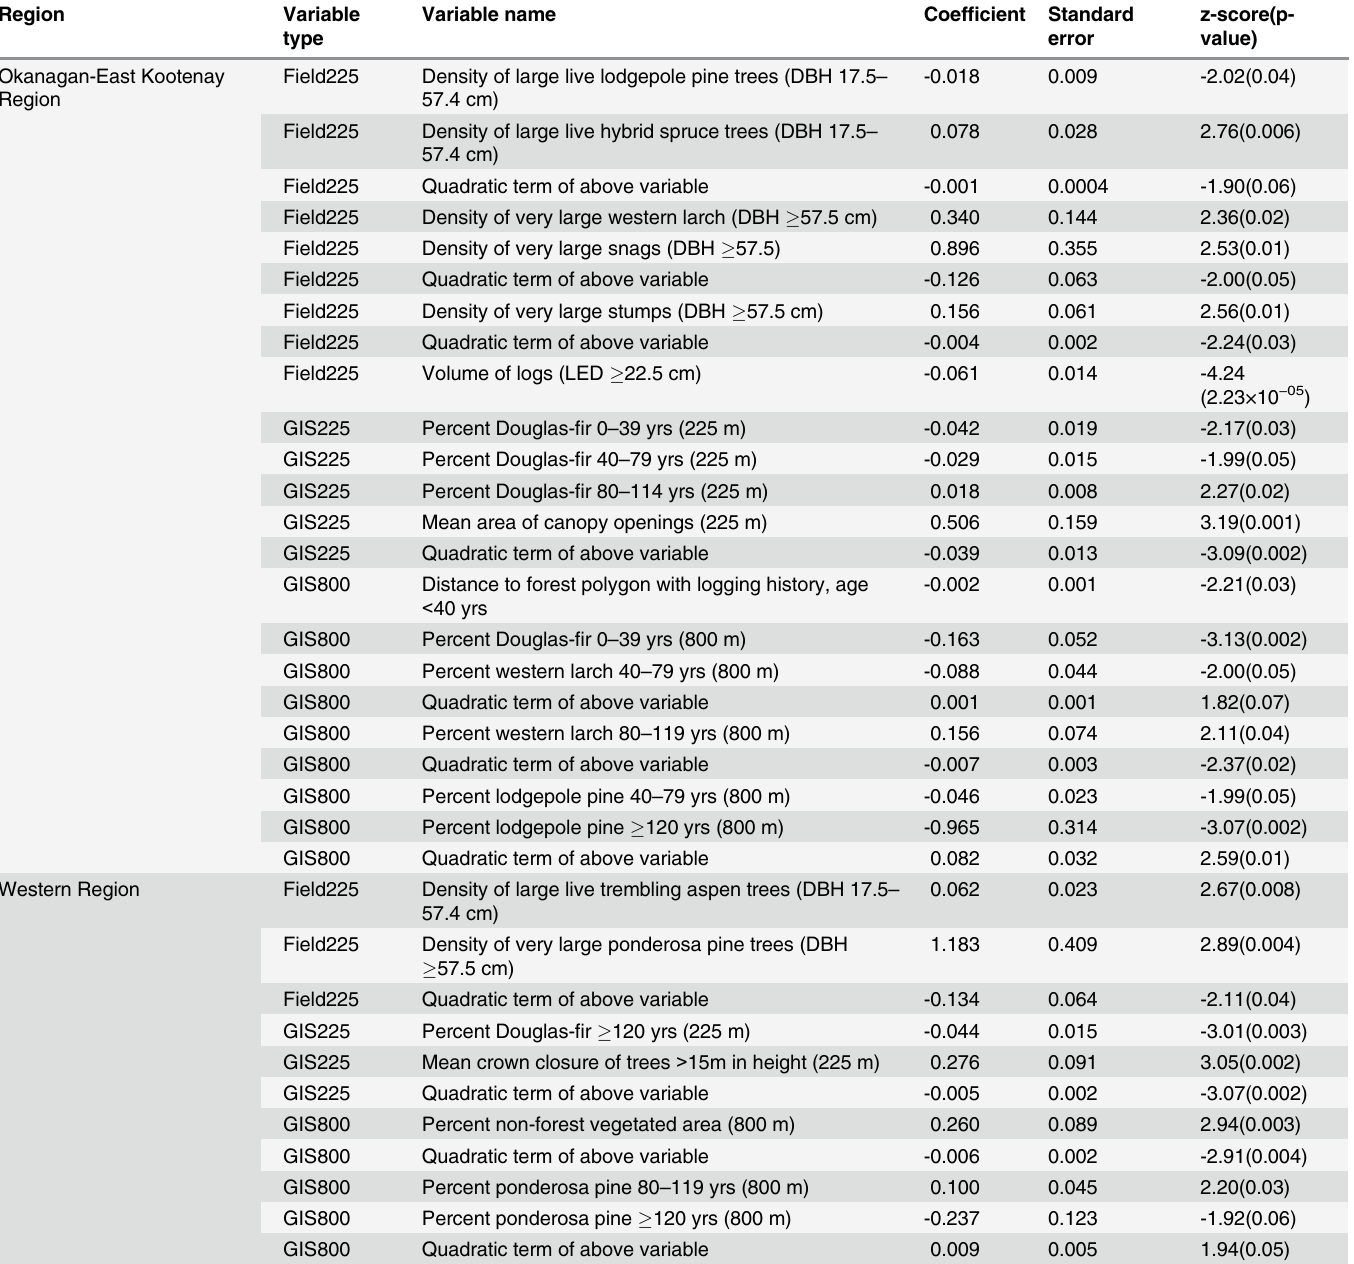
Table 3. Parameter estimates for Field225, GIS225 and GIS800 models explaining Williamson ’ s sapsucker nest occurrence as a function of forest habitat variables in two regions of British Columbia.